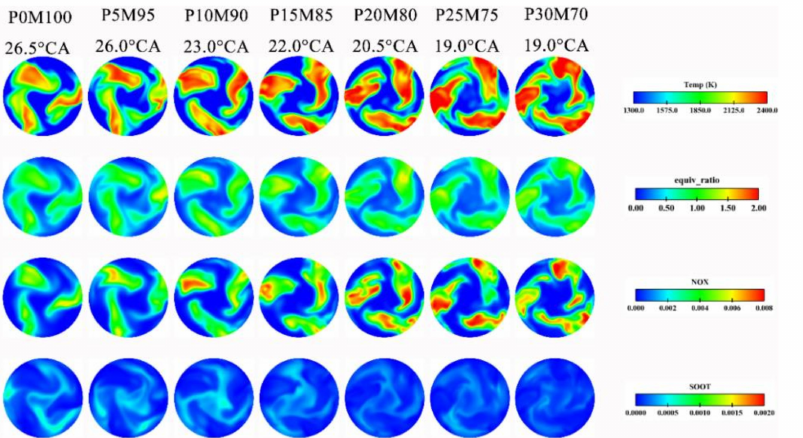
Figure 14. Impact of pilot injection mass ratio on the distribution of temperature, fuel-air equivalence ratio, NOx formation, and soot formation at the moment of 90% accumulative heat release (q90) for various injection cases.